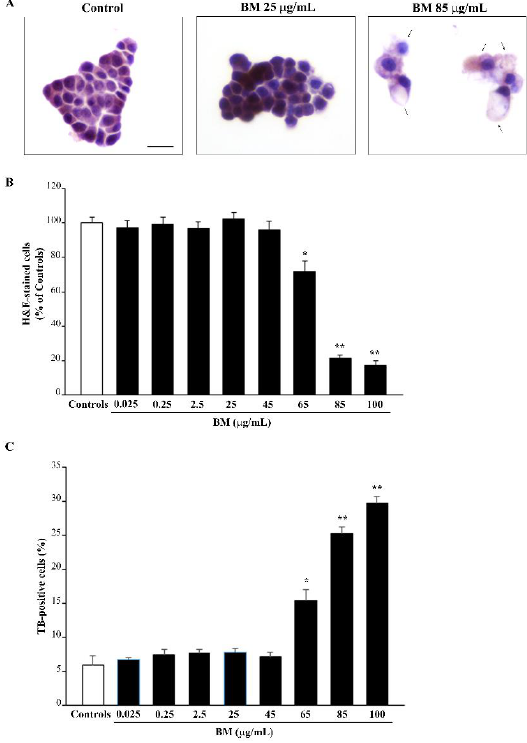
Figure 1. Dose–response of BM on H&E- and TB-stained cells. ( A ) Representative H&E staining, following various doses of BM. Arrows indicate cell alterations induced by high doses of BM. Graphs report the count of ( B ) H&E- and ( C ) TB-stained cells following increasing doses of BM (from 0.025 μ g/mL up to 100 μ g/mL). Values are given as mean percentage ± S.E.M. of cells from three independent experiments. * p < 0.05 compared with controls and BM up to 45 μ g/mL; ** p < 0.05 compared with controls and BM up to 65 μ g/mL. Scale bar = 12 μ m. Similar results are obtained when FJB staining is carried out (representative pictures and graphs of Figure 2). Only high doses of BM, starting from 65 μ g/mL, are neurotoxic and produce an increase in both the number (Figure 2b) and intensity (Figure 2c) of FJB fluorescent cells, while doses of BM below 65 μ g/mL do not differ from controls (Figure 2a).